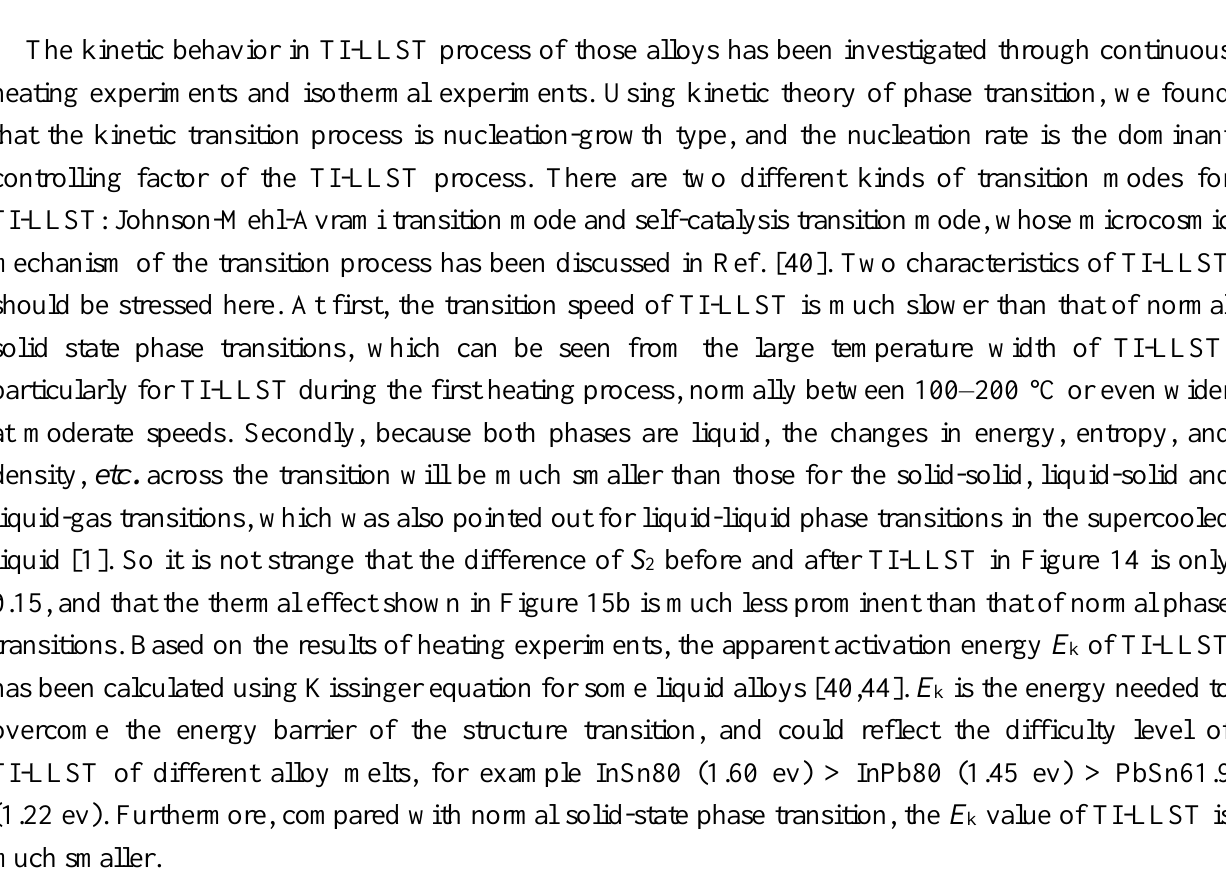
Figure 15. Results of resistivity and DSC analysis for BiSb20 wt% alloy